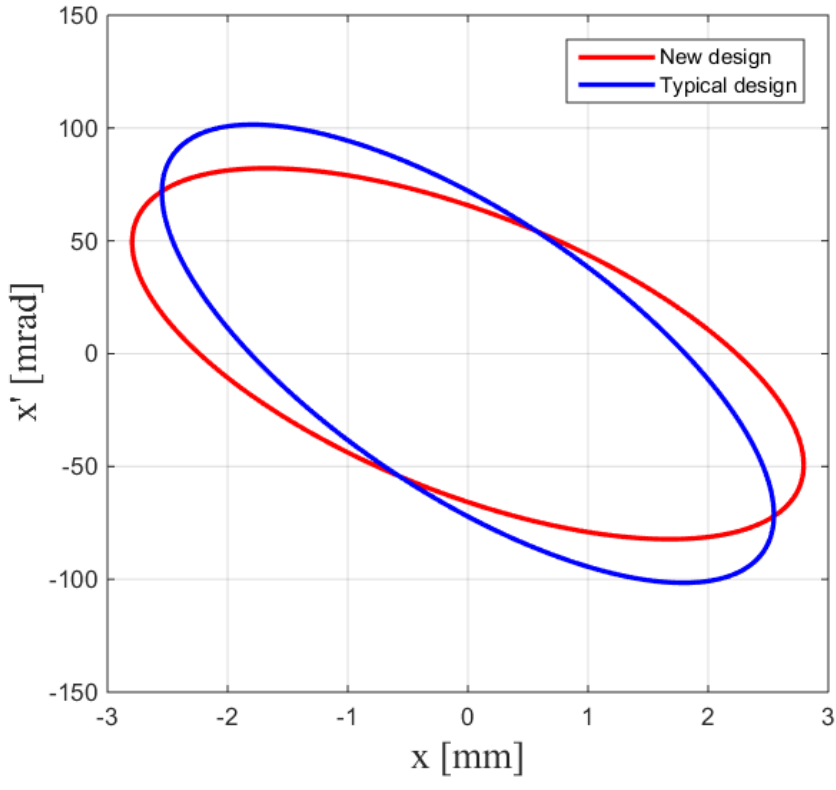
Figure 2. The matched beam ellipse at the entrance of the RFQ under two design methods. New design method (red): 𝛼 = 0.75, and 𝛽 = 0.0425 mm/mrad. Typical design method (blue): 𝛼 = 0.99, and 𝛽 = 0.0353 mm/mrad.